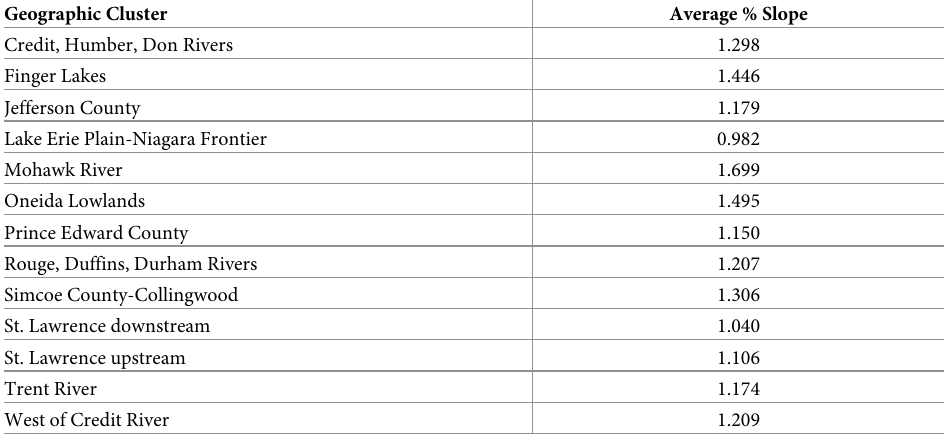
Table 6. Average percent slope for Tobler’s Hiking Function LCPs from one centroid to all other centroids. Geographic Cluster